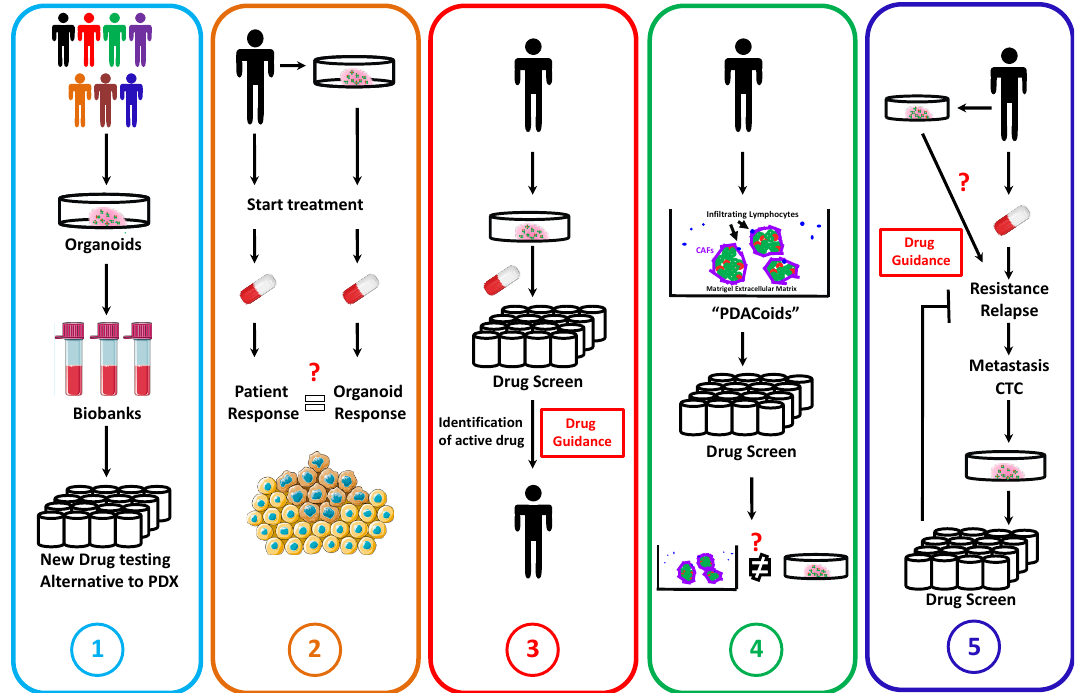
Figure 3. Current and future applications of PDAC organoids in personalized medicine. ( 1 ) Creation of biobanks of PDAC organoid cell lines allowing for the validation of new treatments during pre-clinical studies. ( 2 ) Validation of organoids as drug predicting tool. ( 3 ) “Real-time” drug guidance for PDAC patients using organoids. Isolation of organoids and drug test will allow us to determine the most efficient therapy against the patient PDAC. ( 4 ) Development of “ PDACoids ” to improve the drug sensitivity prediction and to test whether they are providing a better prediction than conventional tumor organoids. ( 5 ) Strategy involving organoids to counteract drug resistance acquisition and to propose alternative therapeutic strategies. After the relapse, if possible, a second metastasis biopsy or the isolation of circulating tumor cells will allow for the isolation of resistant organoids and determine an alternative to the former therapy. Adapted from [49]. Creative Commons Attribution 3.0 Unported License Servier Medical Art by Servier.